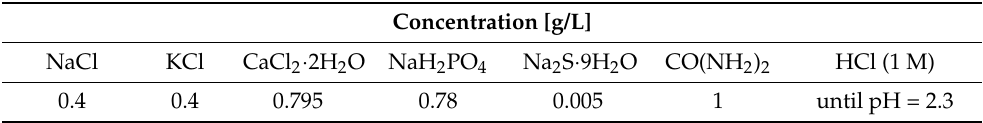
Table 1. Chemical composition of the Fusayama-Meyer artificial